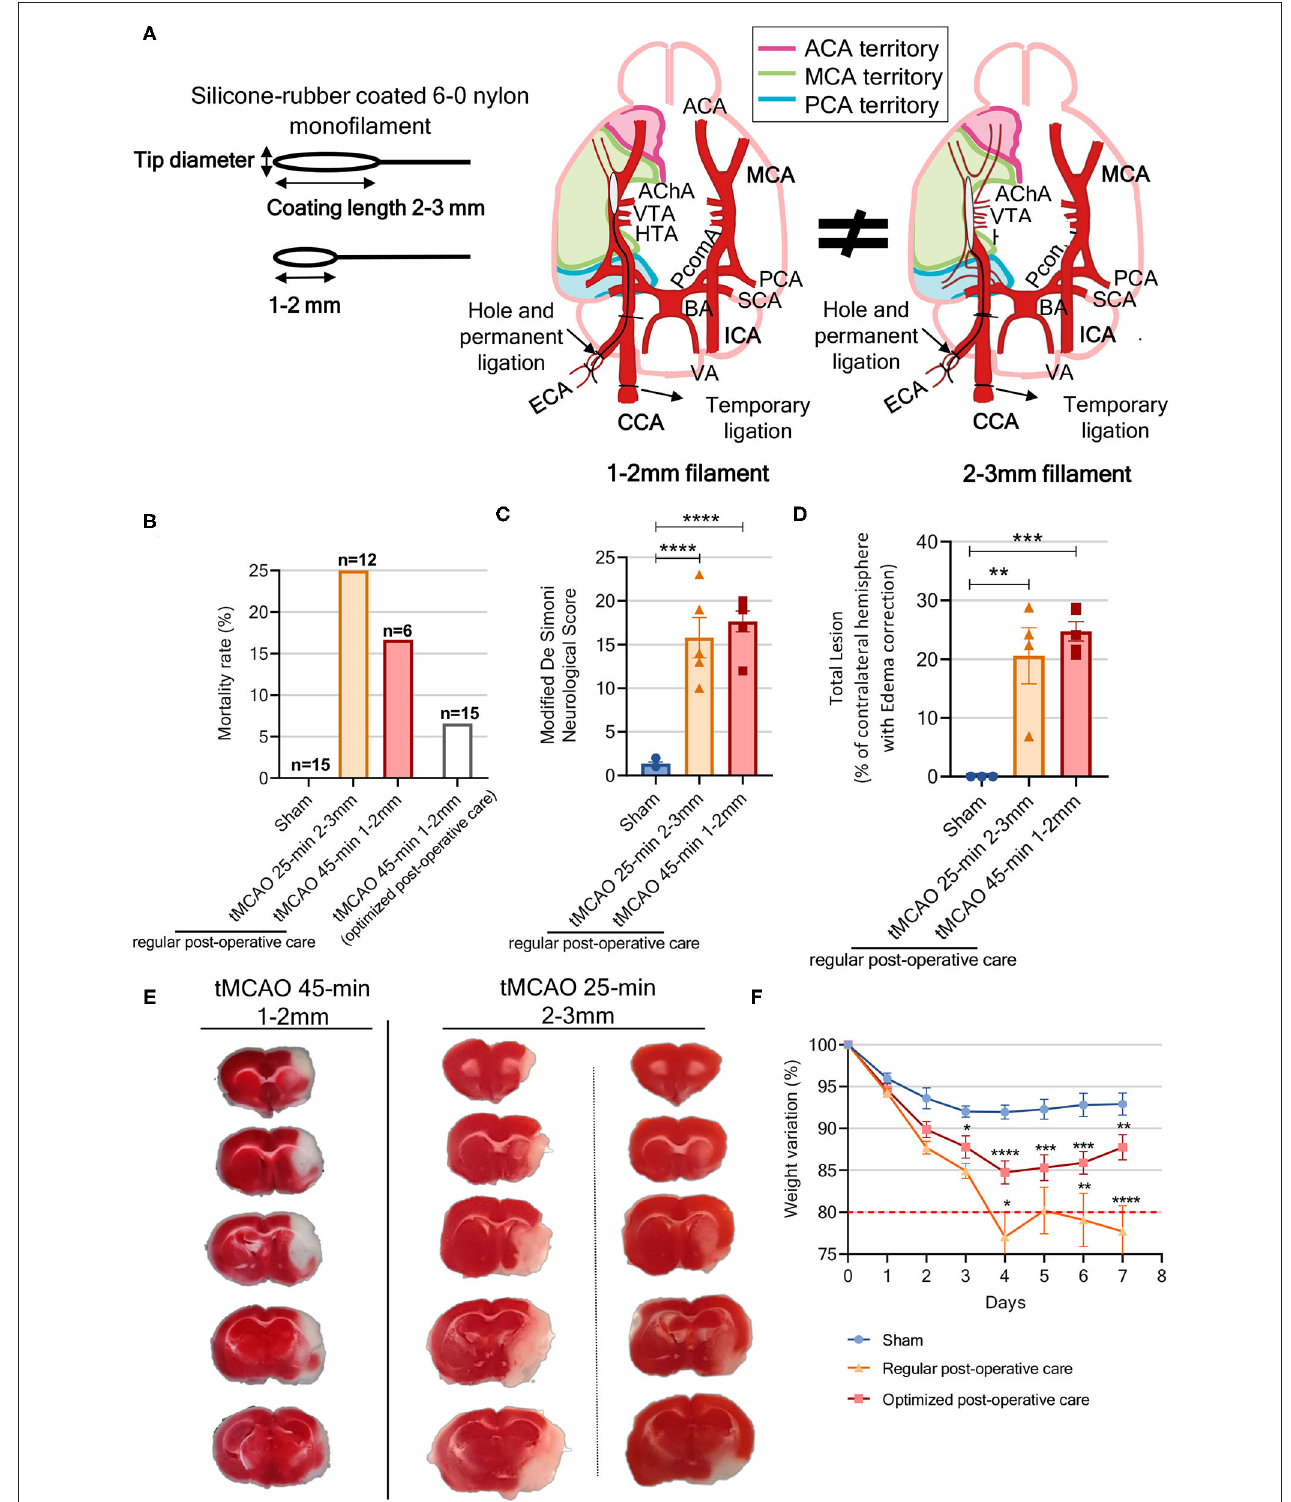
FIGURE 2 | Improving tMCAO surgery parameters and postoperative protocol to shorten the gap between preclinical and clinical stroke studies. (A) Schematic of nylon sutures with different silicone coated tip diameters and lengths; suture coating lengths used varied between 1–2 and 2–3mm, while suture tip diameter varied according to animal pre-surgery weight, and schematic diagram of different arteries that become occluded with different suture types, which lead to different territories